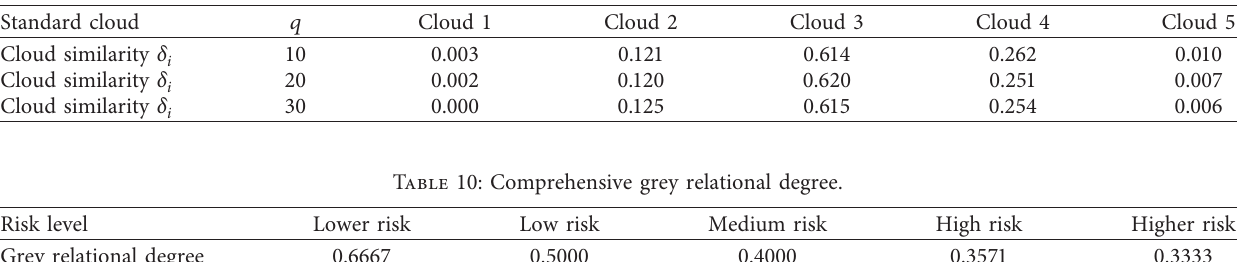
Figure 2: Cloud of comprehensive evaluation. Table 9: Calculation results of the cloud similarity.